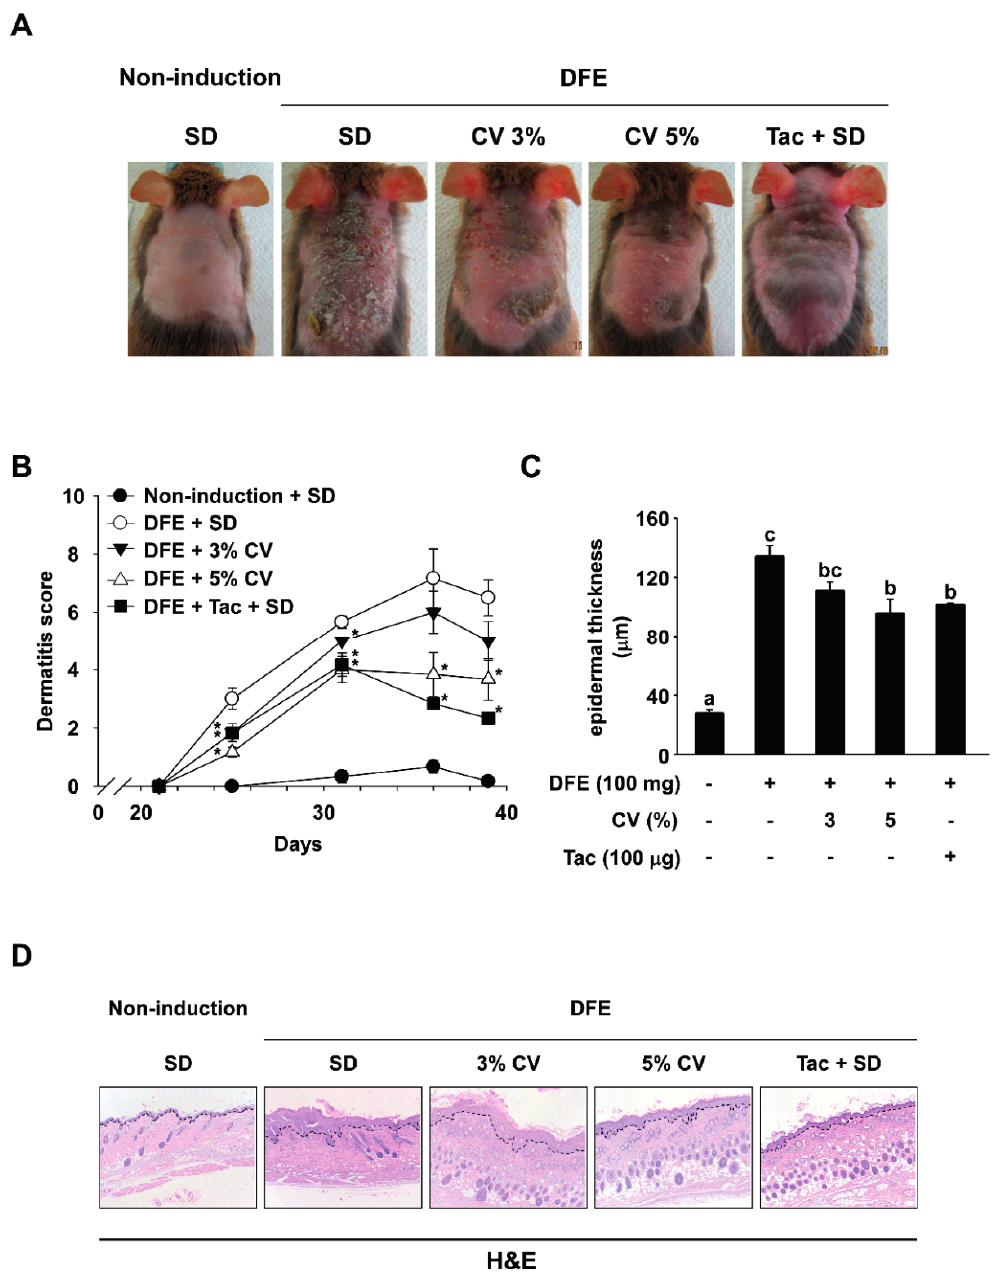
Figure 1. Effect of CV on DFE-induced AD-like symptoms in NC/Nga mice. (A) Skin lesions typical of AD. Images of skin lesions were taken in the sixth week; ( B ) Dermatitis scores. The scoring represents a clinical index that was evaluated each week from Day 21 to 39; ( C ) Epidermal thicknesses of skin lesions were measured until the final week; ( D ) H&E stained skin recovered in the sixth week (100×). Dotted lines indicate epidermal hypertrophy. Data represent mean values ± SEM ( n = 6). Mean values with letters (a–c) within a graph are significantly different from each other at p < 0.05. ( * p < 0.05, Student’s t -test). CV: Chlorella vulgaris ; DFE: Dermatophagoides farinae extract; AD: atopic dermatitis; H&E: hematoxylin and eosin; Tac: